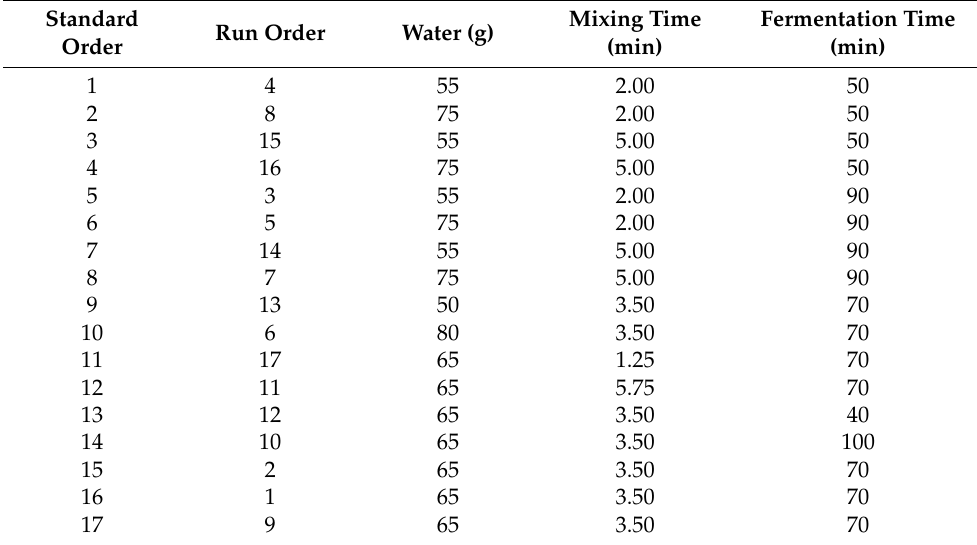
Table 1. Experimental design in formula and processing conditions for the preparation of bread with flour–bran blend at 30%